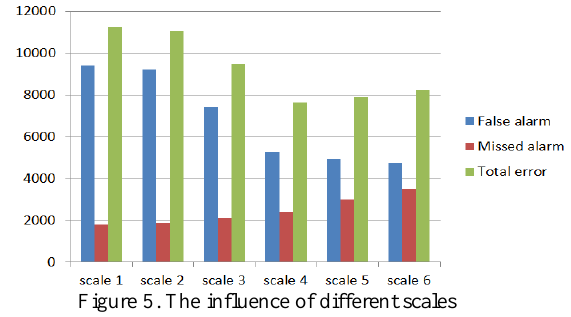
Figure 5. The influence of different